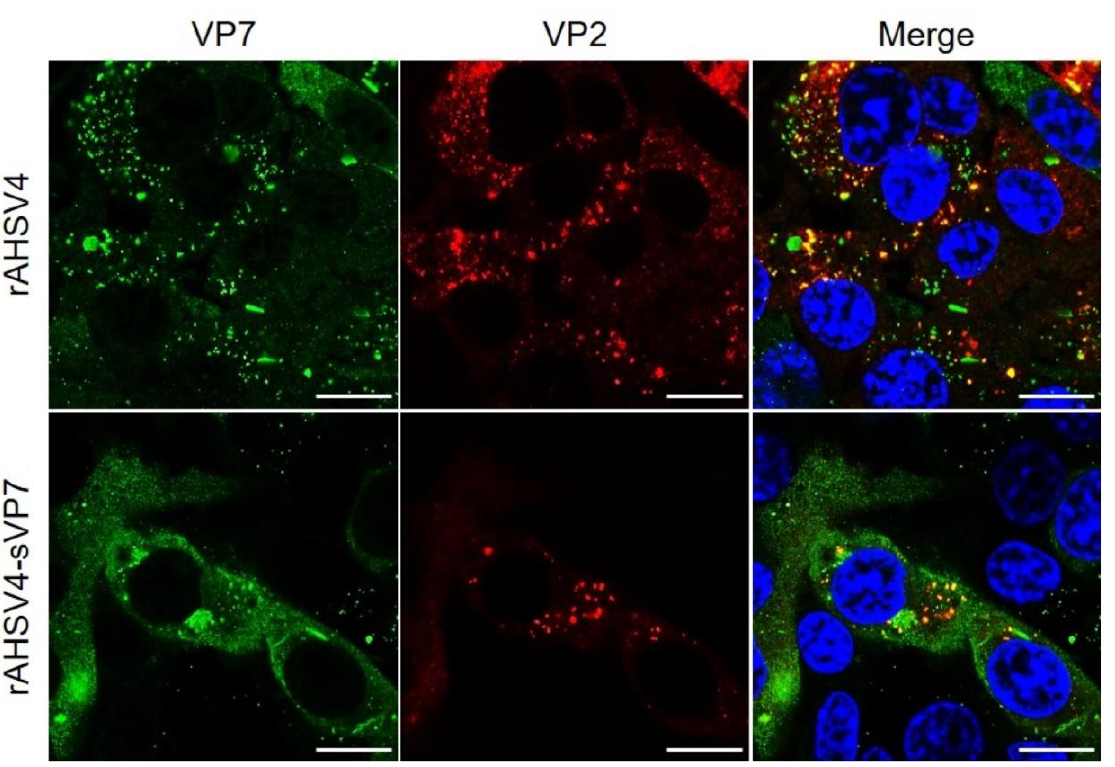
Figure 2. Intracellular distribution and colocalisation of AHSV VP7 and outer capsid protein VP2 in wild-type rAHSV4 (top panel) and mutant rAHSV4-sVP7 (bottom panel). BSR cell monolayers, seeded on coverslips, were infected at a MOI of 0.1 of each virus, incubated for 48 h, fixed and labelled as described in Section 2.5. VP7 was labelled with anti-VP7 guinea pig primary antibody and detected using Alexa Fluor 488 anti-guinea pig secondary antibody (green). VP2 was labelled with anti-VP2 mouse primary antibody and detected using Alexa Fluor 594 anti-mouse secondary antibody (red). Nuclei were stained with DAPI (blue). Images are split into separate channels (green and red) with channels merged on the right. Areas of colocalisation are indicated by yellow in merged images. Scale bars represent 10 µm.